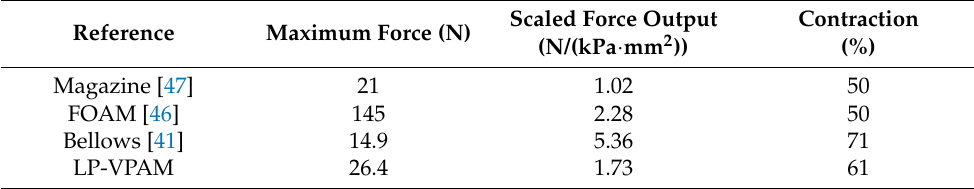
Table 3. Comparison of our LP-VPAM with performance of similar VPAMs in the literature. Scaled force output and percent contraction for the magazine spring, FOAM, and bellows actuators. Scaled force output is calculated by dividing actuator force output by actuation pressure and cross-sectional area, as seen in